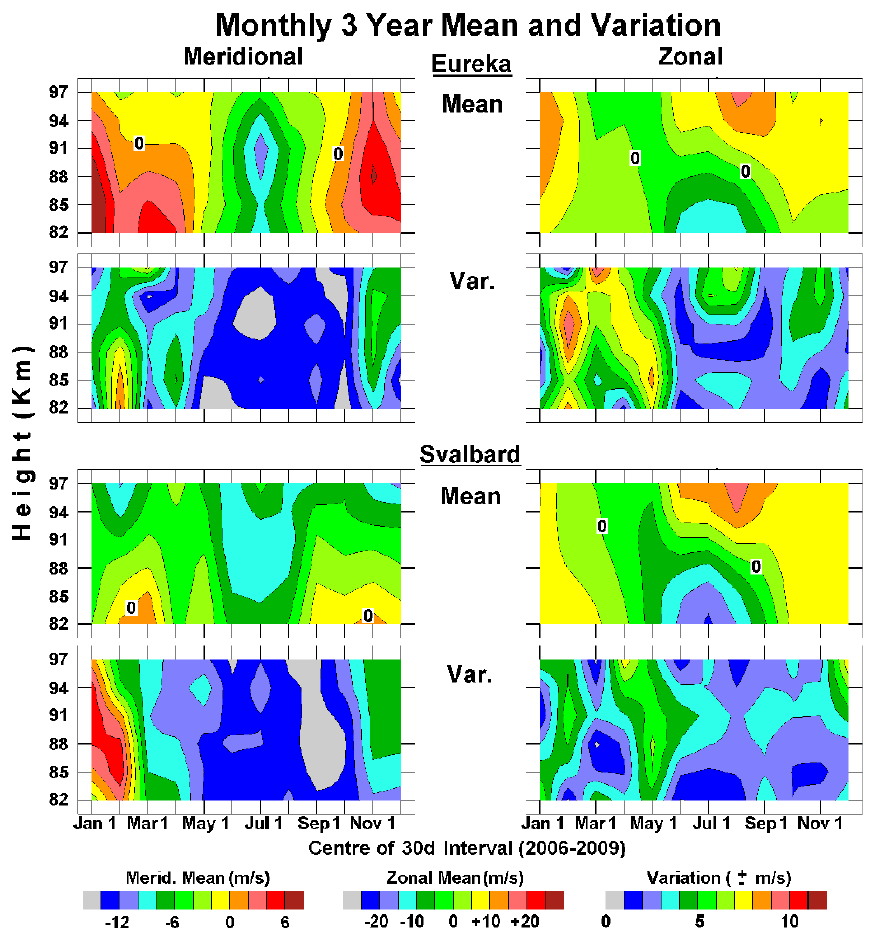
Fig. 1. Three-year means (averages of the background winds) for 30-day intervals between 15 February 2006 and 15 February 2009: these are from fits for the mean winds and 12- and 24-h tidal oscillations. The intervals have the first day of each month as their mid-point, and contours result from a bilinear interpolation procedure. The “variations” of the background winds over three years are provided as well; they are defined as [100(maximum − minimum)/(maximum + minimum)]%, and are used as an indicator of the IAV (Inter-Annual Variability)...year-to-year